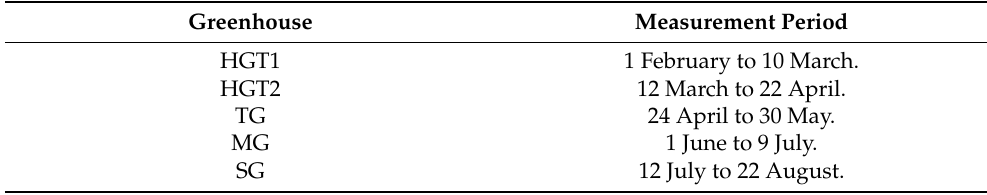
Table 7. Periods of experimental evaluation in each of the greenhouses.